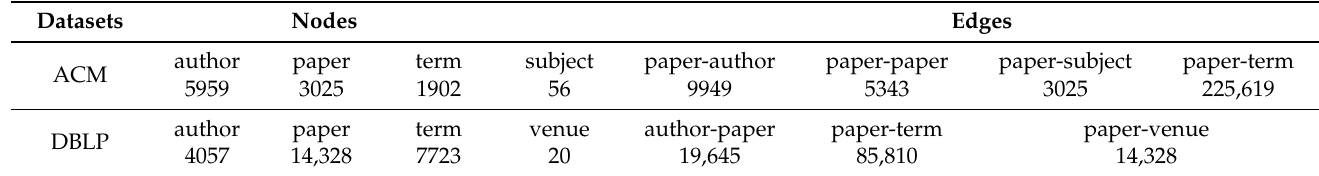
Table 2. Statistics of ACM and DBLP